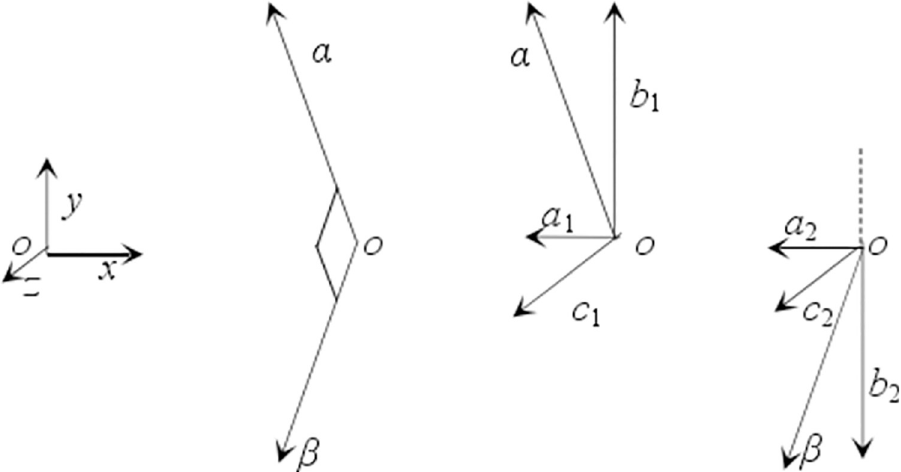
Fig 6. Decomposition of two vertical direction